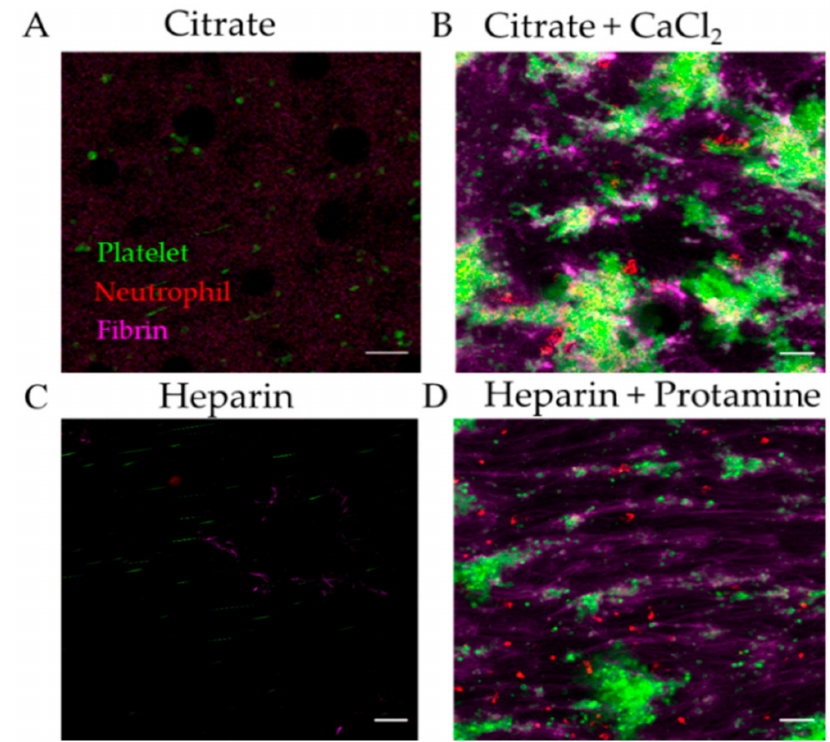
Figure 4. Effect of anti-coagulant on performance of the thromboinflammation chip. Representative images of fibrin (magenta), platelet (green), and neutrophil (red) adhesion on endothelialised chip ( A ) without or (B ) with recalcification of citrated blood with 10 mM CaCl 2 ; ( C ) without or ( D ) with addition of protamine to heparinized blood. Scale bar represents 20 µ